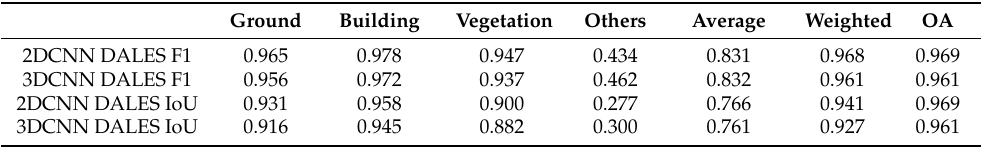
Table 17. Average and weighted F1 and IoU scores for the 2DCNN and 3DCNN classifiers trained on DALES dataset and predicted on Bordeaux dataset. The OA is also reported.